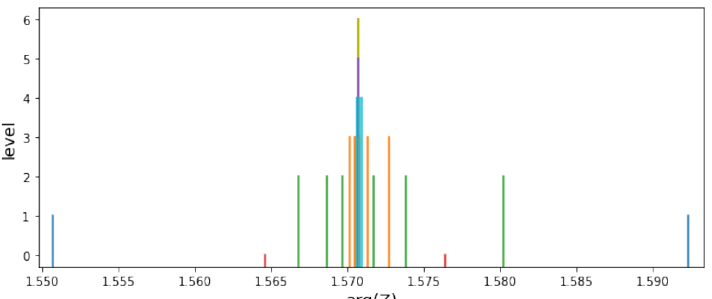
Figure 19 . BPS spectrum between ˜ γ (2) (leftmost) and ˜ γ (3) (rightmost) for m = 50 i , δ kcut = 4 , subcut = 1 , and lvlcut = 7 . There are high level secondary states between γ γ γ γ 1 + 2 + f (shown in red), which are the result of overlapping bound state families. and vectors of the form γ 3 + ˜ γ ( k ) wall-crossing with ˜ γ ( k − 1) with pairing zero as seen in the m = 3 , δ 0 . 15 case. We can also again find vector states involved in wall-crossings | | ≈